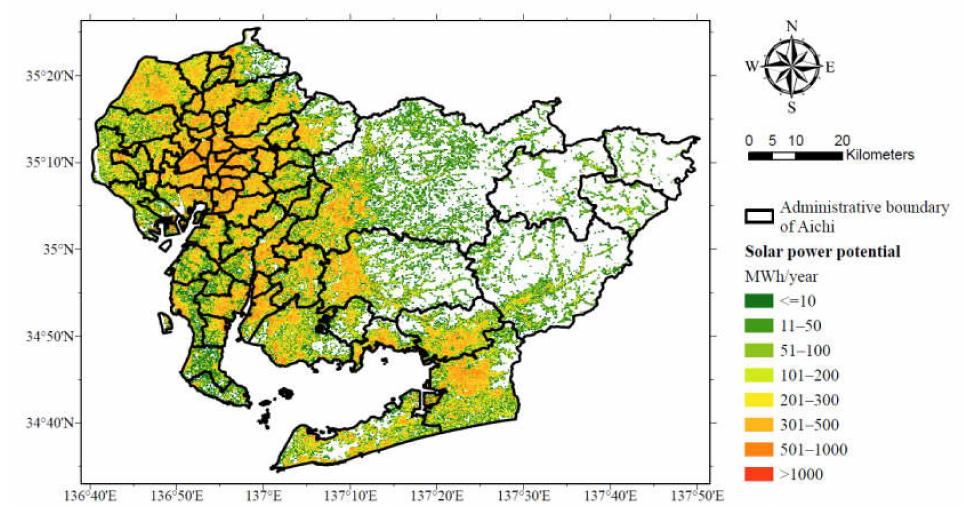
Figure 10. Estimated annual rooftop solar power generation amount in Aichi Prefecture under Scenario B (the results were summarized into a 125 m